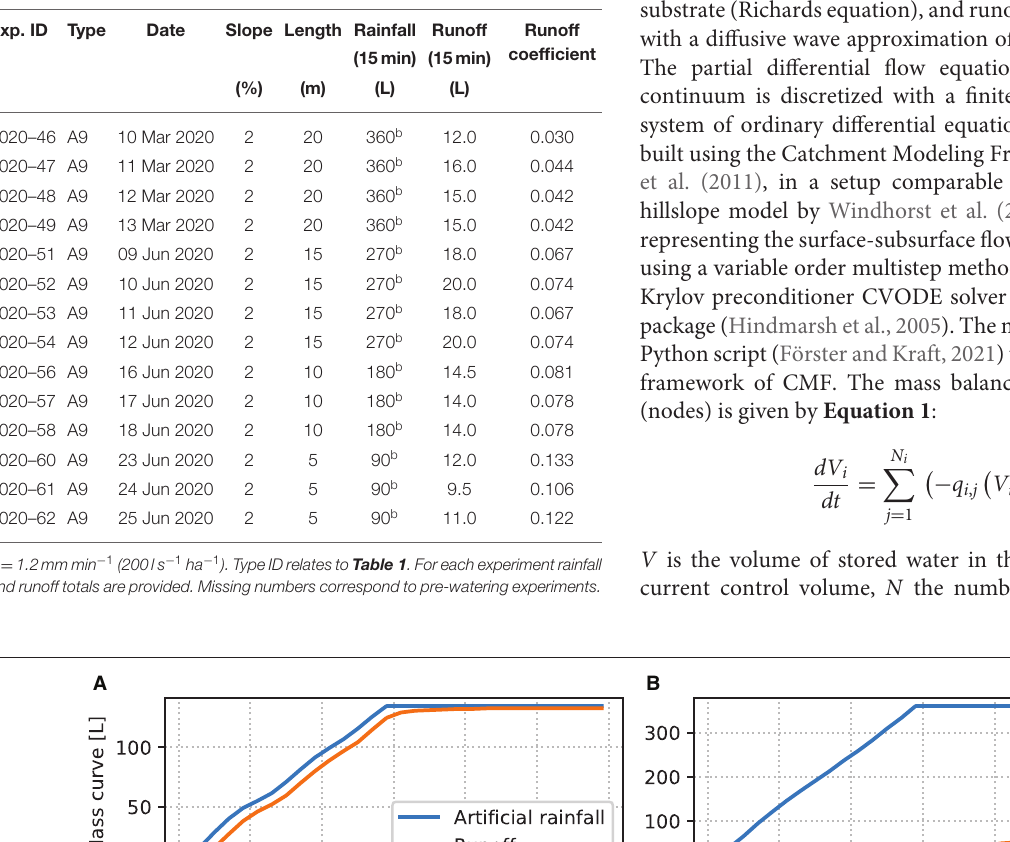
Frontiers in Water |